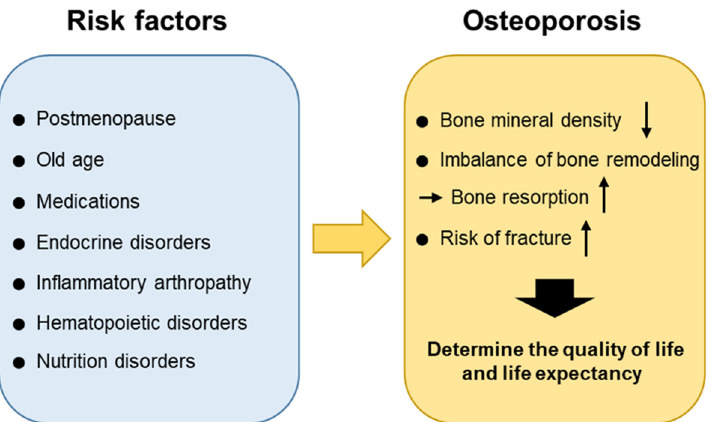
Figure 1. Risk factors for osteoporosis. Risk factors can cause an imbalance in the remodeling process leading to osteoporosis. The postmenopausal period and old age are the major causes of osteoporosis.